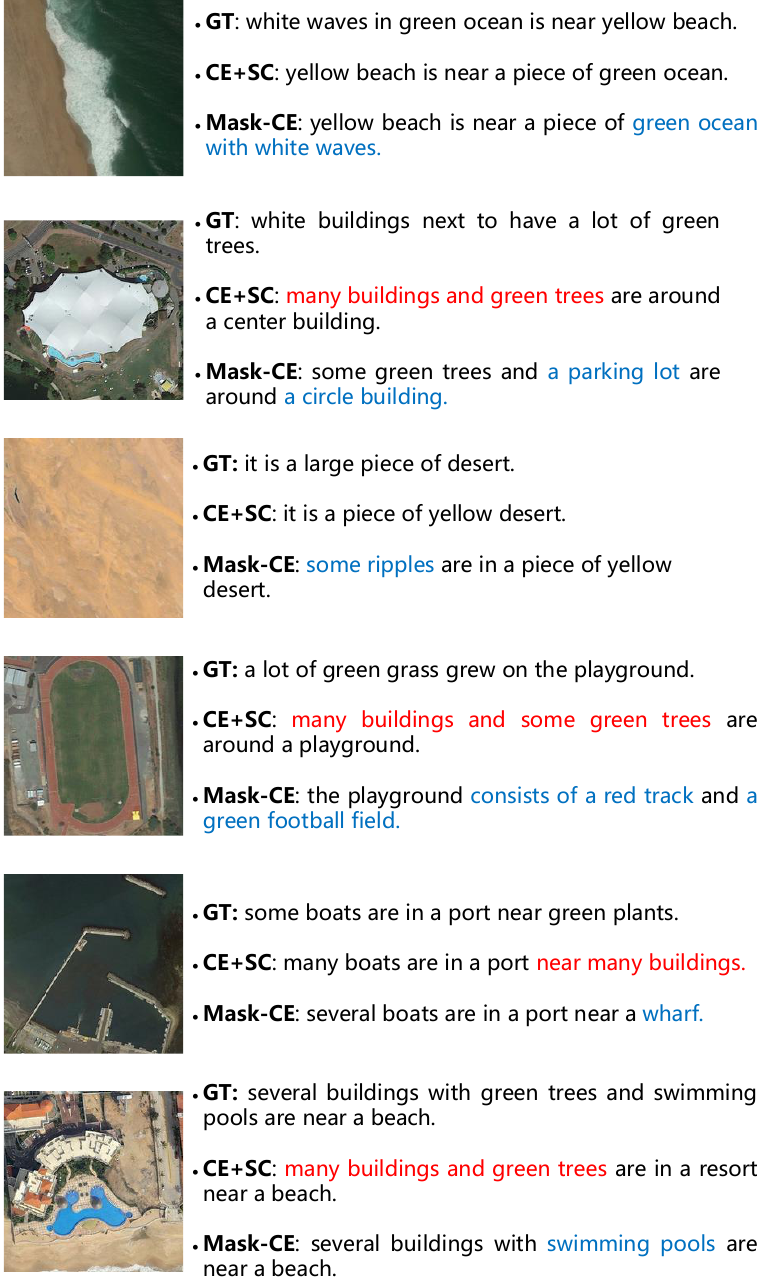
Figure 8. Sentence comparison under different training strategies. The GT is one of the ground-truth sentences, CE with SC and Mask-CE are two different sentences generated in two corresponding training stages. Some common words are colored in red, and the diverse words are colored in